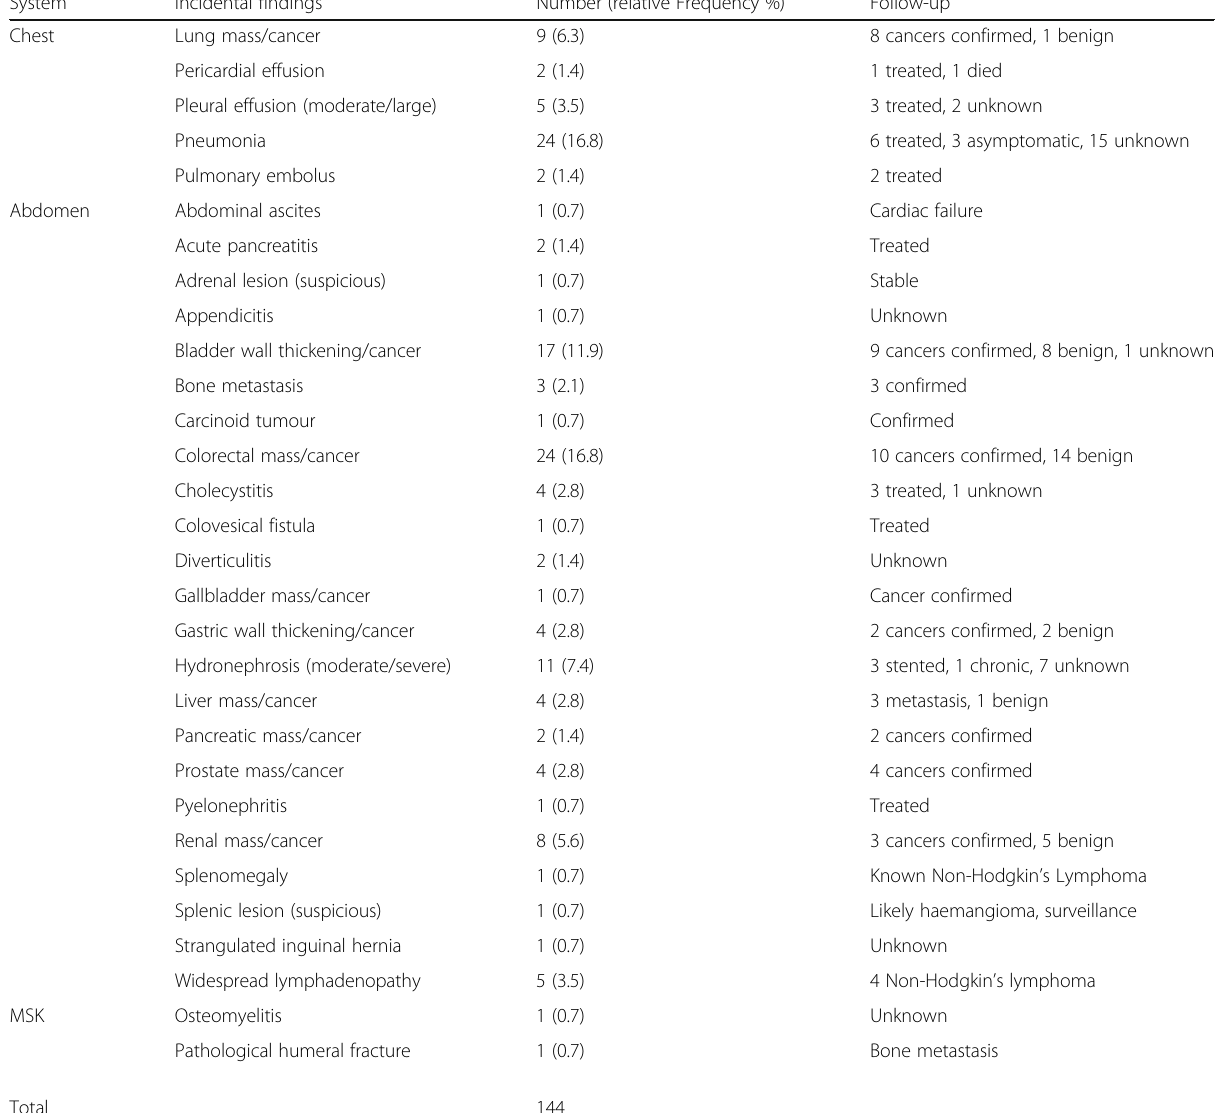
Table 1 Class I extravascular incidental findings according to system area. (MSK denotes musculoskeletal)